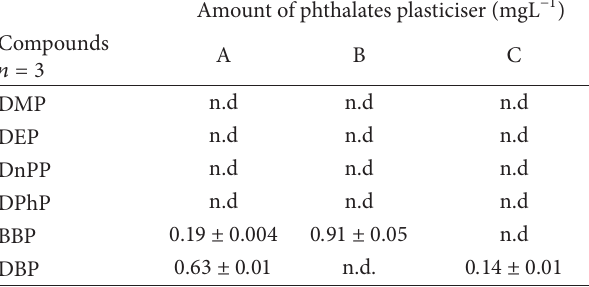
Table 6: The amount of phthalates plasticiser in different palm oil